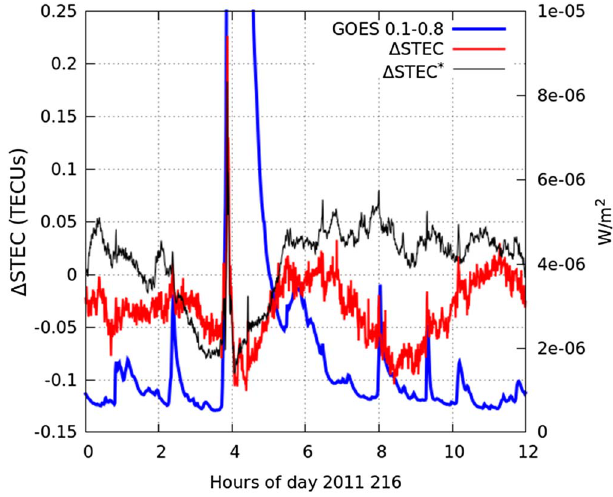
Fig. 8. NASA-GOES data (blue) and values of D STEC and D STEC* during an SF at 04:00 UTC. The case corresponds to the DoY 216 (August 8) in